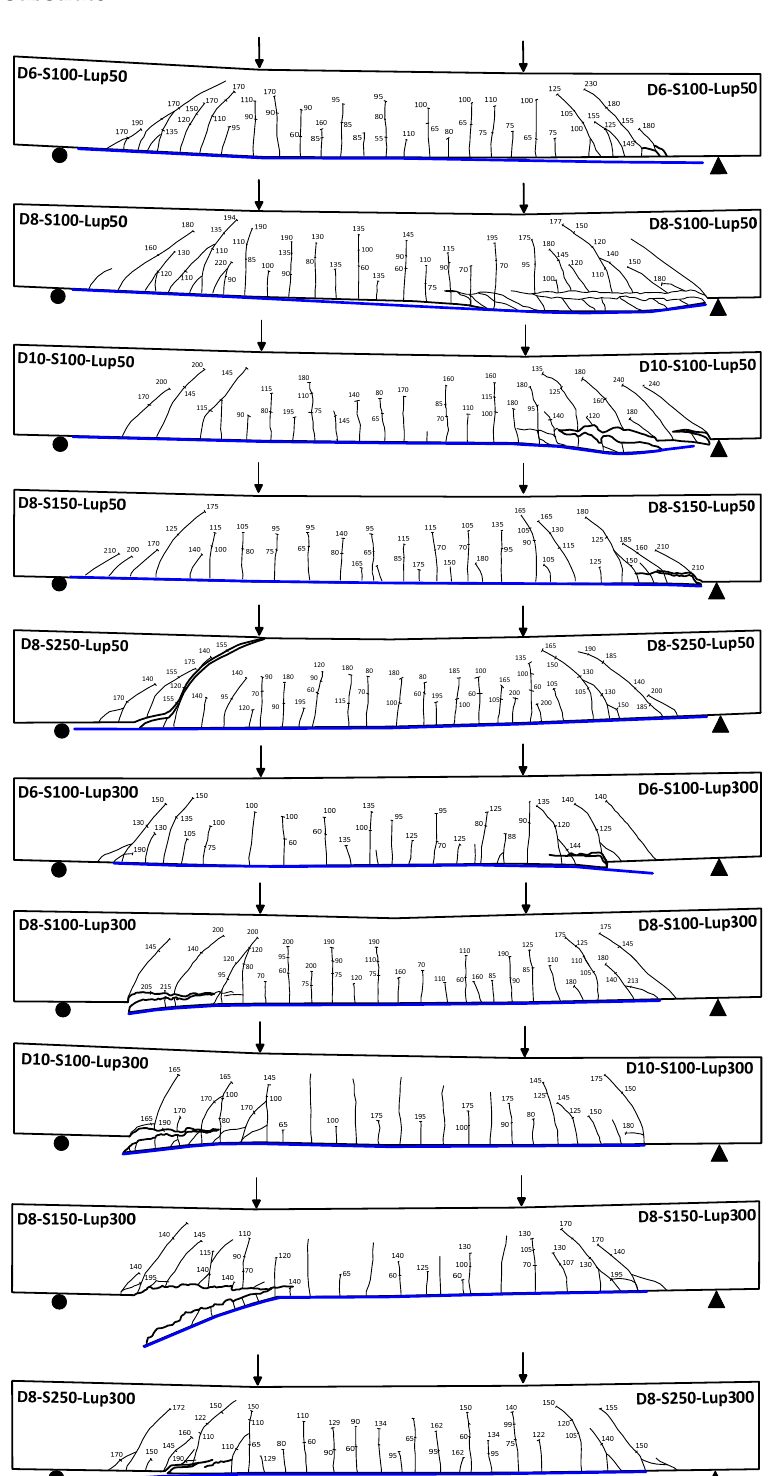
Figure 4. Cracking patterns of the tested beams at failure.